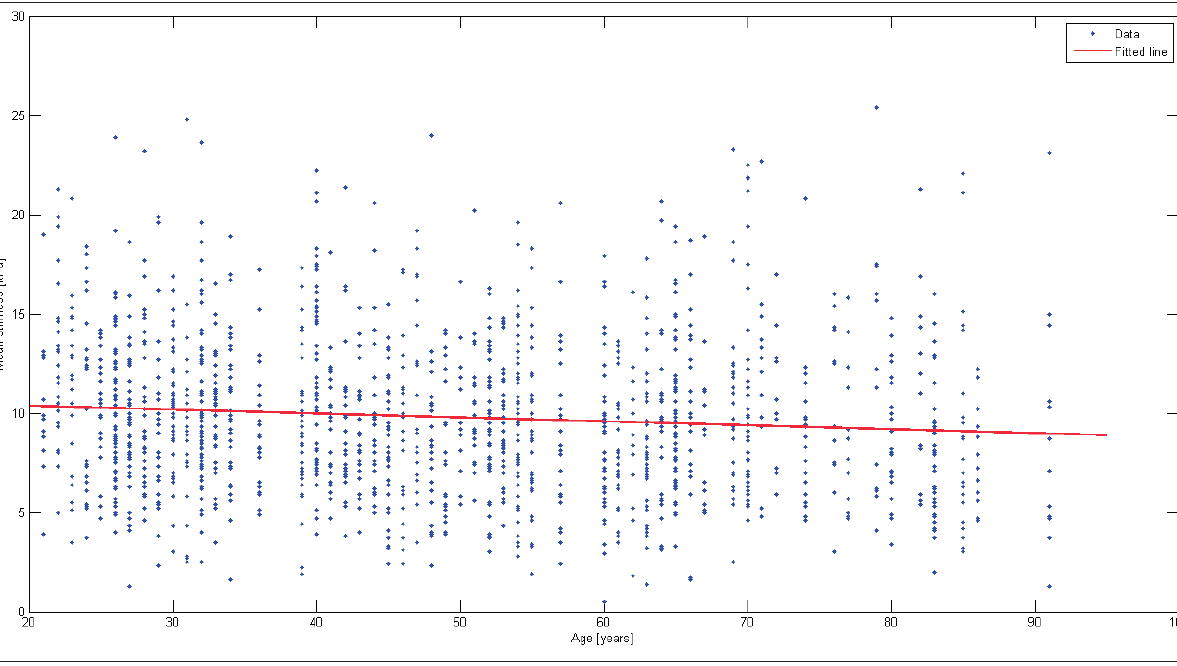
Fig. 3. Effect of age on stiffness of all the tissues studied, scatter plot, decreasing line of the slope −0.020 [kPa/year], 95% confi- dence interval for the slope: [−0.031,